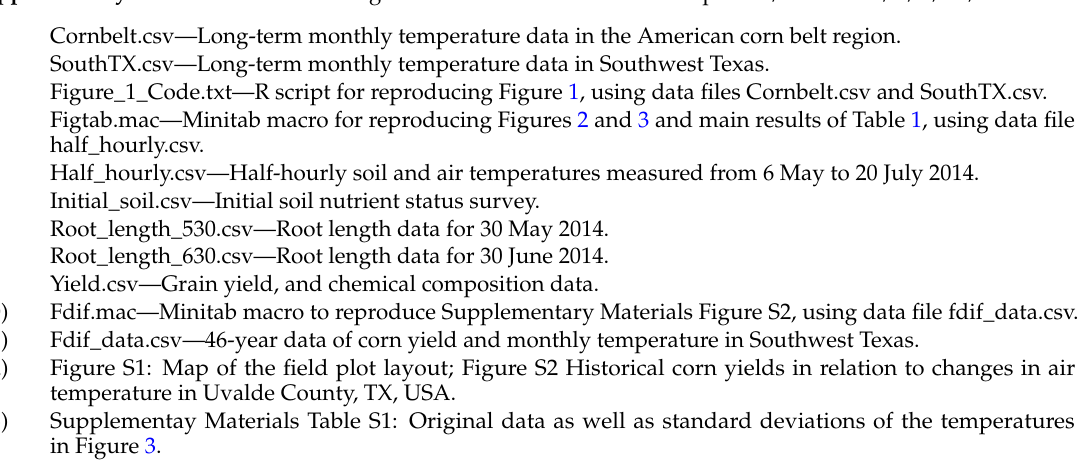
Figtab.mac—Minitab macro for reproducing Figures 2 and 3 and main results of Table 1, using data file half_hourly.csv.